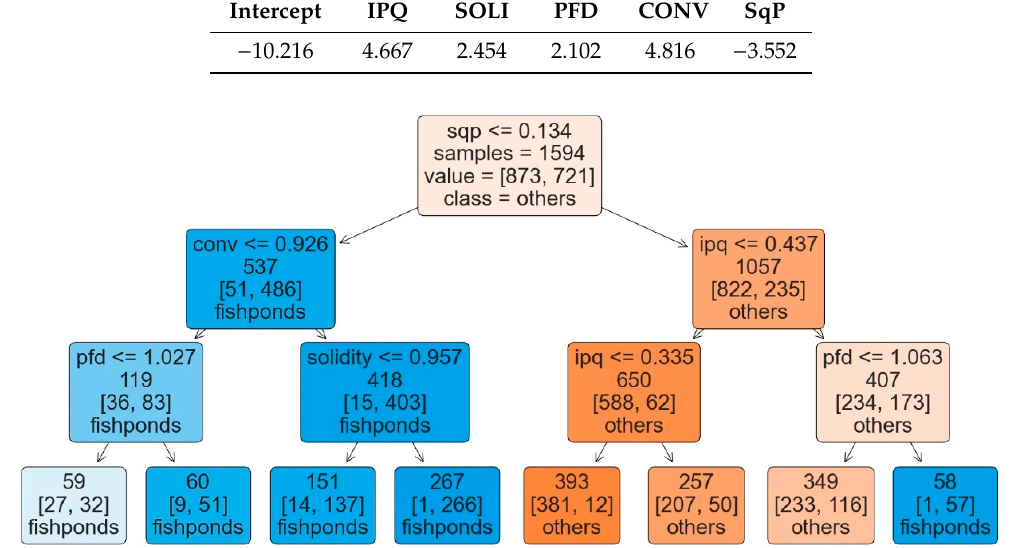
Figure 5. Decision Tree (DT) tree structure (blue nodes indicate fishpond class, and orange nodes indicate other water types). Table 4. Five-fold cross validation score of implemented Logistic Regression (LR) and DT models.